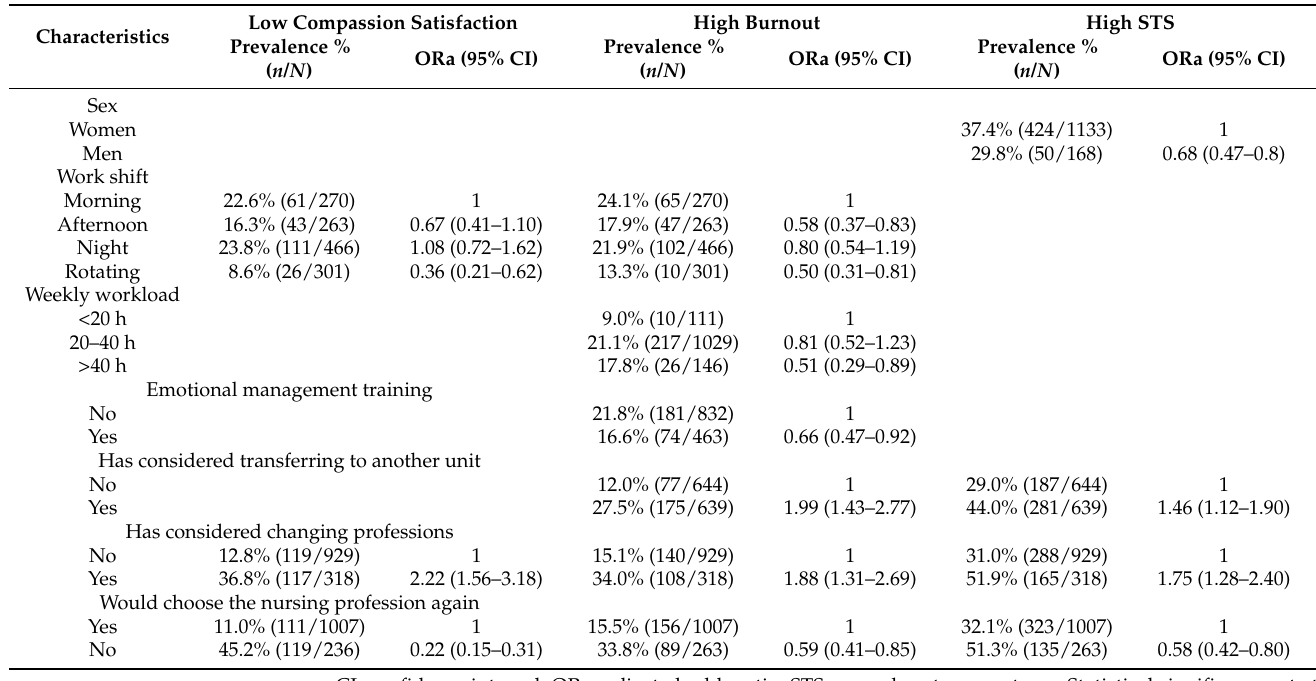
Table 3. Factors associated with CS, burnout, and STS, according to the Professional Quality of Life (ProQOL) questionnaire.